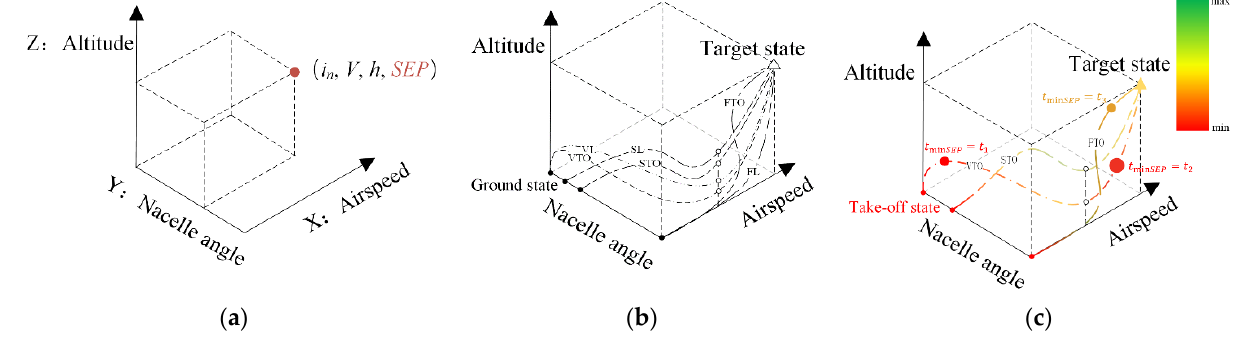
Figure 4. ( a ) Coordinates information for the point in 3D envelope; ( b ) climb and descend curves